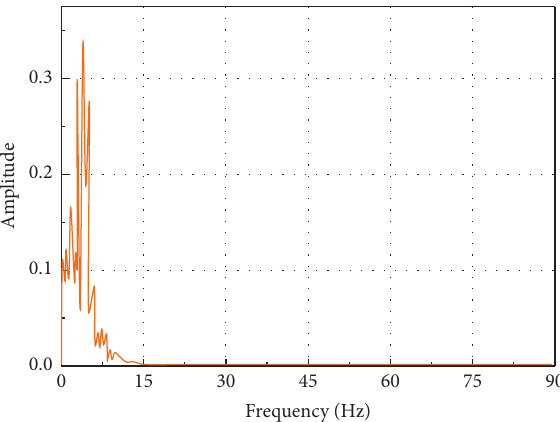
Figure 5: Spectrum of monitoring point in simulation.